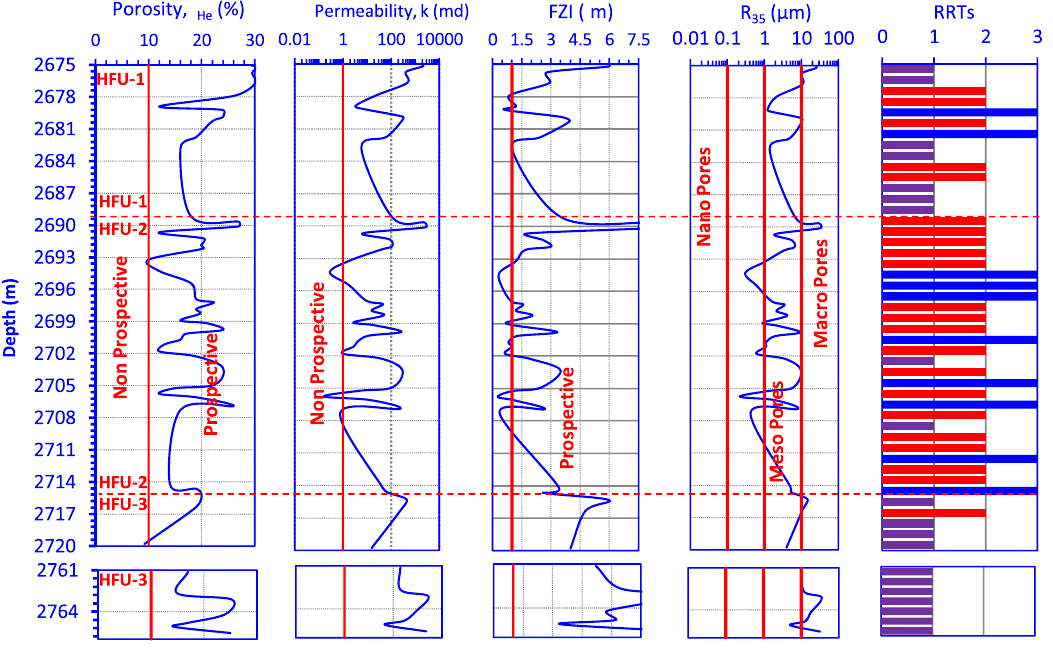
Fig. 19 Vertical presentation of the petrophysical data derived from the core data and their reservoir rock types (RRTs) for the M (depth interval 2675–2720 feet) and L1 (depth interval 2761–2766 feet)